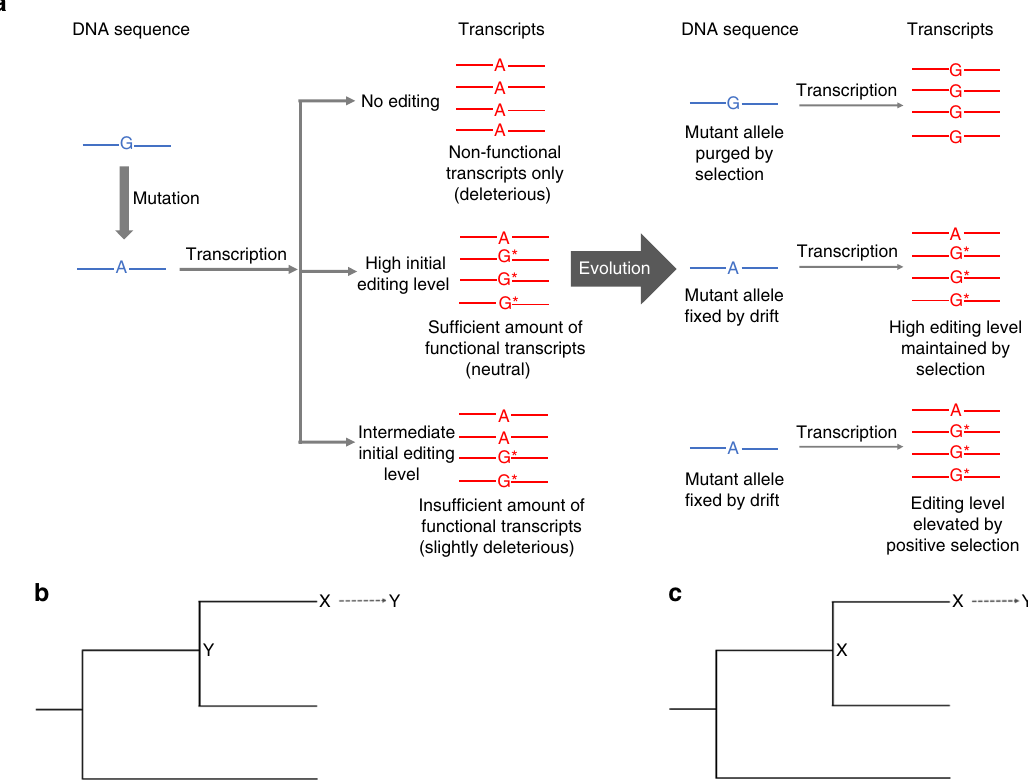
Fig. 1 The harm-permitting model and a strategy to detect the harm-permitting effect. a The harm-permitting effect of nonsynonymous editing. The top row shows that, when a nonsynonymous A site is not edited (or is subject to a low level of editing), a G-to-A mutation at the site is too deleterious to get fi xed. The middle row shows that, when the site is highly edited, the G-to-A mutation becomes neutral and is fi xed by genetic drift. The high editing level is then selectively constrained. The bottom row shows that, when the editing level of the site is intermediate, the G-to-A mutation is slightly deleterious and fi xed by genetic drift. The editing level may be further elevated by positive selection (or maintained by negative selection). Despite the relatively high nonsynonymous editing levels in the middle and bottom rows, no adaptation (i.e., no net increase in fi tness) occurred when the fi nal genotype is compared with the original genotype. DNA is shown in blue, whereas RNA is in red. Post-edited nucleotides are marked with stars. b Restorative editing restores an ancestral amino acid state lost upon an amino acid substitution, which may have occurred in the exterior branch as shown here or in an earlier branch. In other words, the post-editing state is identical to an ancestral pre-editing state. c Diversifying editing creates an amino acid state that differs from pre- editing states in a set of ancestors considered. Although only the state of one ancestor is shown here, the states of multiple ancestors may be considered. In b and c , X and Y represent different amino acid states, whereas the arrow shows the effect of editing. Restorative but not diversifying editing can confer